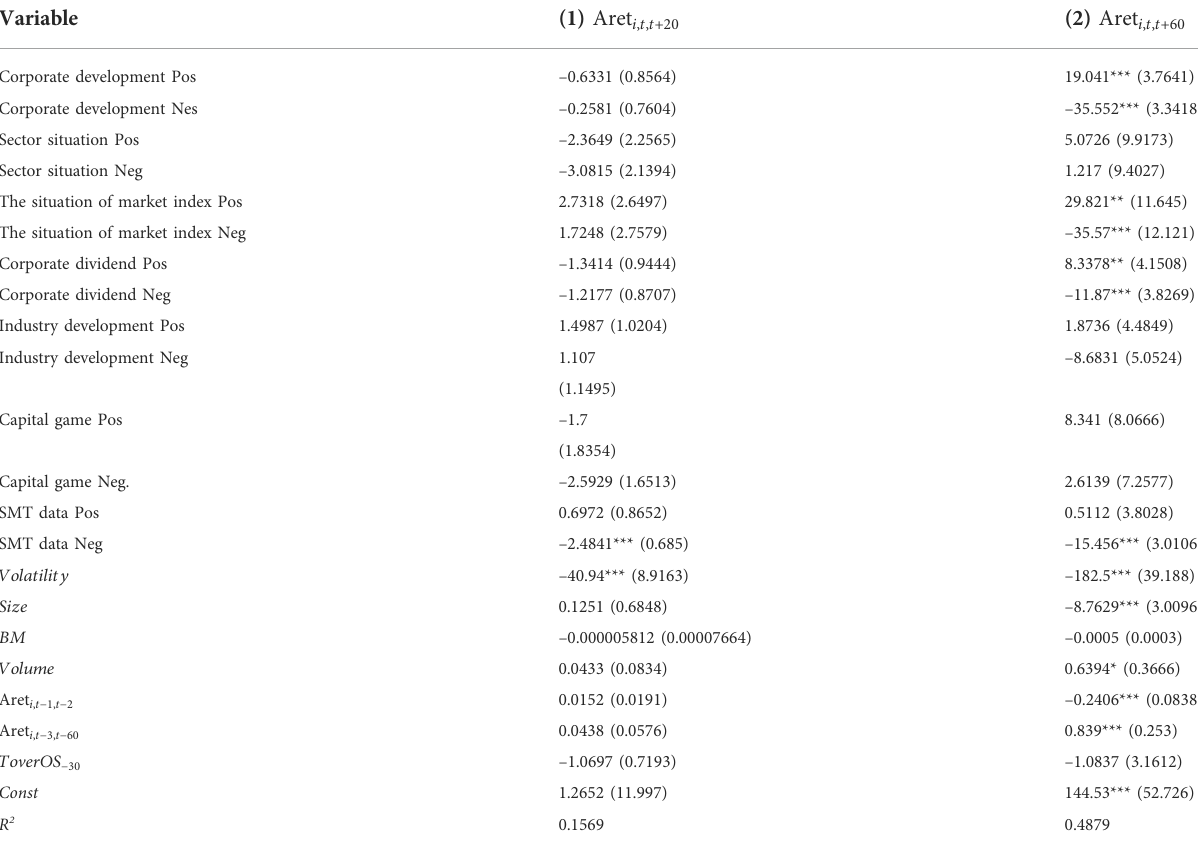
TABLE 5 Asymmetric